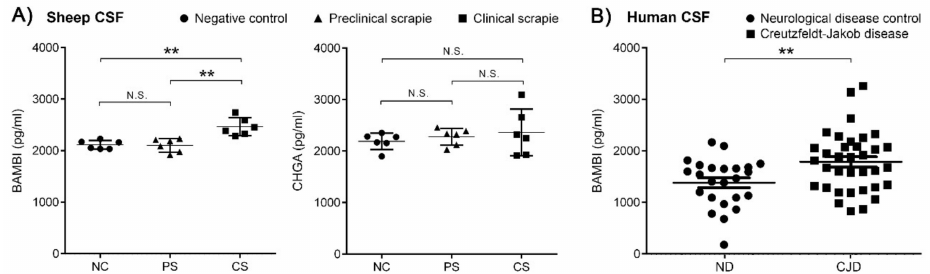
Figure 8. ELISA quantification of BAMBI and CHGA proteins in CSF of scrapie-infected sheep and BAMBI in CSF of CJD patients. ( A ) Intensity of BAMBI and CHGA signals in CSF of control (NC, round dots) and scrapie sheep at preclinical (PS, triangular dots) and clinical stage (CS, square dots). Protein BAMBI displayed an upregulation in CSF of scrapie-a ff ected sheep at clinical stage (2465 ± 174 pg / mL) compared to scrapie sheep at preclinical stage (2103 ± 132 pg / mL, p < 0.01) and to control sheep (2114 ± 84 pg / mL, p < 0.01). No significant di ff erences were detected between groups for CHGA protein. ( B ) Concentrations of BAMBI in CSF of control (ND, round dots) and CJD cases (square dots). This protein displayed increased concentrations in CJD (1771 ± 588 pg / mL) compared to ND (1370 ± 474 pg / mL, p < 0.01). N.S.: no statistically significant value. Di ff erences between groups